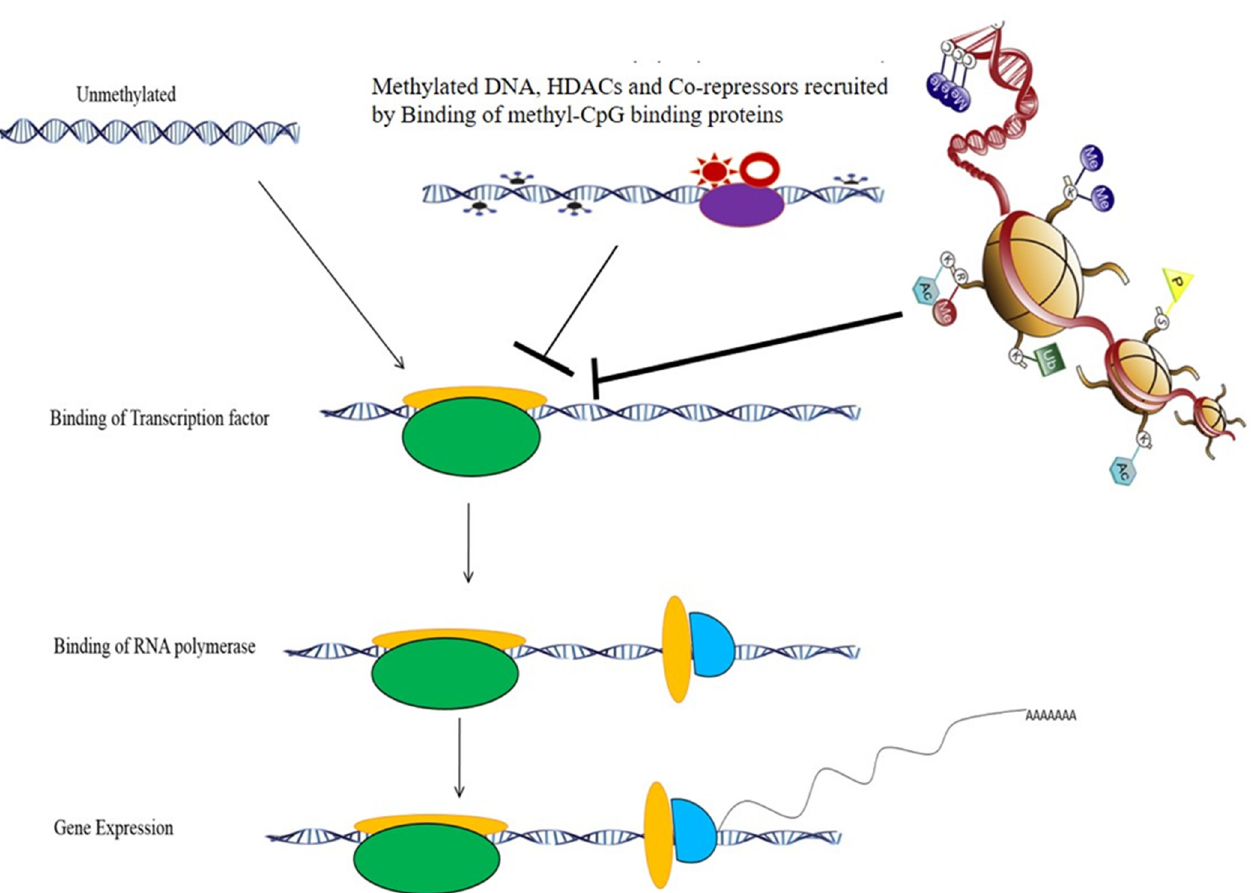
Figure 1. Effect of DNA methylation on gene expression. DNA methylation at the promoter site of a gene recruits the methyl CpG binding protein, which further recruits histone deacetylases and transcriptional repressors, which repress gene expression .